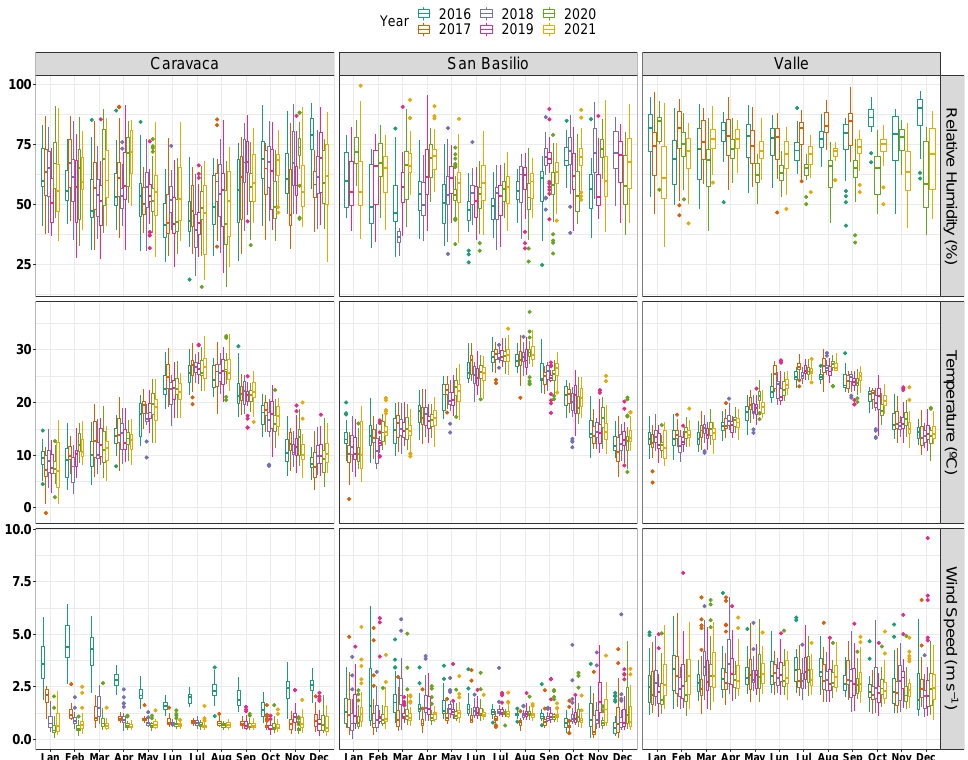
Figure 3. Box and whiskers plots of the daily relative humidity, temperature, and wind speed data at the three stations (Caravaca, San Basilio, and Valle). The bottom and top of the box represent the first and the third quartiles, respectively; the horizontal line in the box represents the median; dots are the outliers; whiskers the lowest and highest values, excluding the